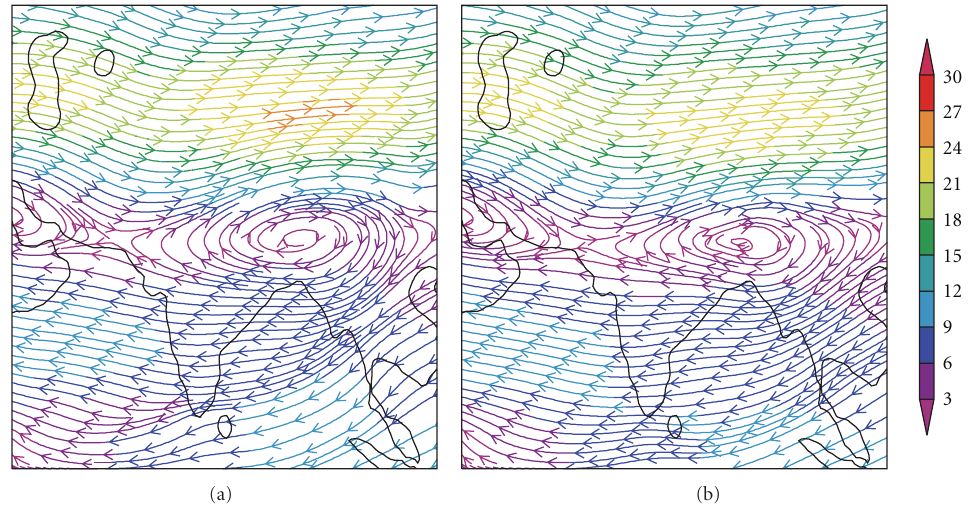
Figure 5: Mean wind fields (wind vectors) and wind speed at 300hPa (m/s; colours) for HIRHAM (a) and ERA40 (b); summer monsoon (JJAS)